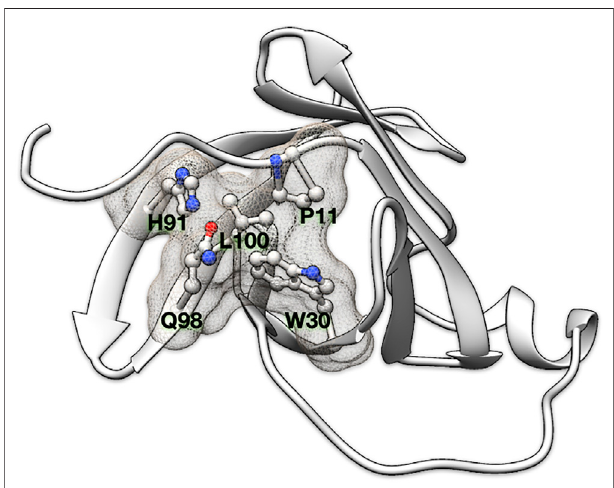
FIGURE 1 | Residue clique of amino acids. A 5-residue clique (P11, W30, H91, Q98, and L100) of cut-off 7.5 Å shown in ball and stick representation and enveloped with a meshed molecular surface from human recombinant MTCP-1 protein (PDB: